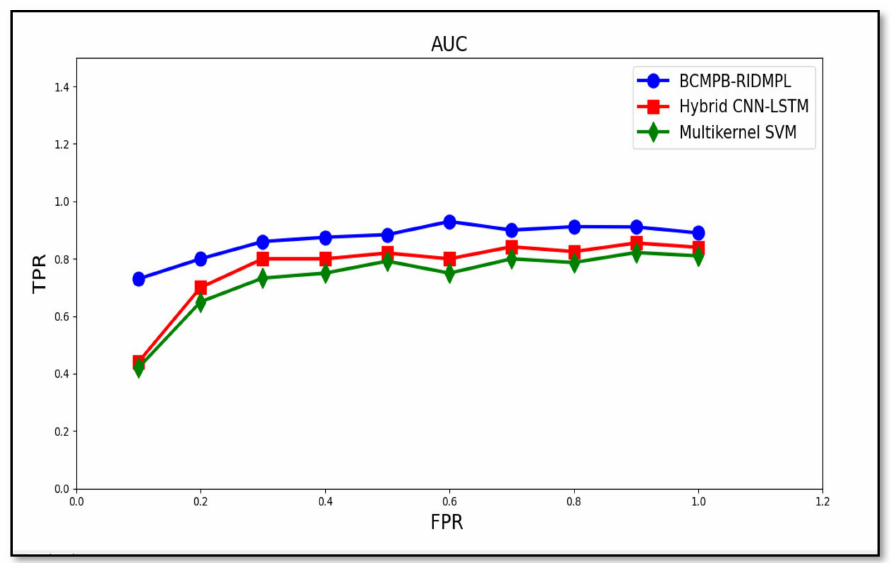
Figure 10. AUC measure of performance of the proposed malware detection technique for BCMPB- RIDMPL, CNN-LSTM and multi-kernel SVM